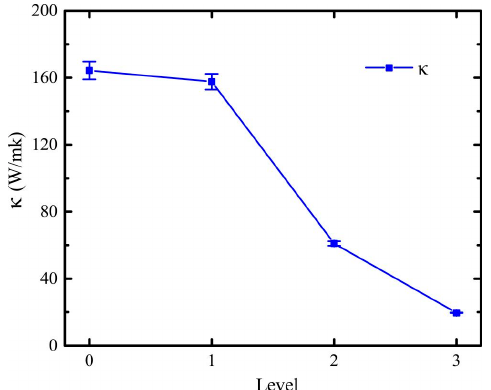
Figure 4. Effect of fractal levels on thermal conductivity of graphene with Sierpinski fractal structures. The cases represent the models of different fractal levels, and the level numbers 0, 1, 2, and 3 represent the structures of gra0, gra1, gra2, and gra3, respectively.